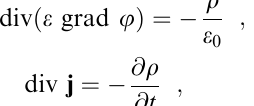
Fig. 16. Idealized circuit of the current system shown in Fig. 11